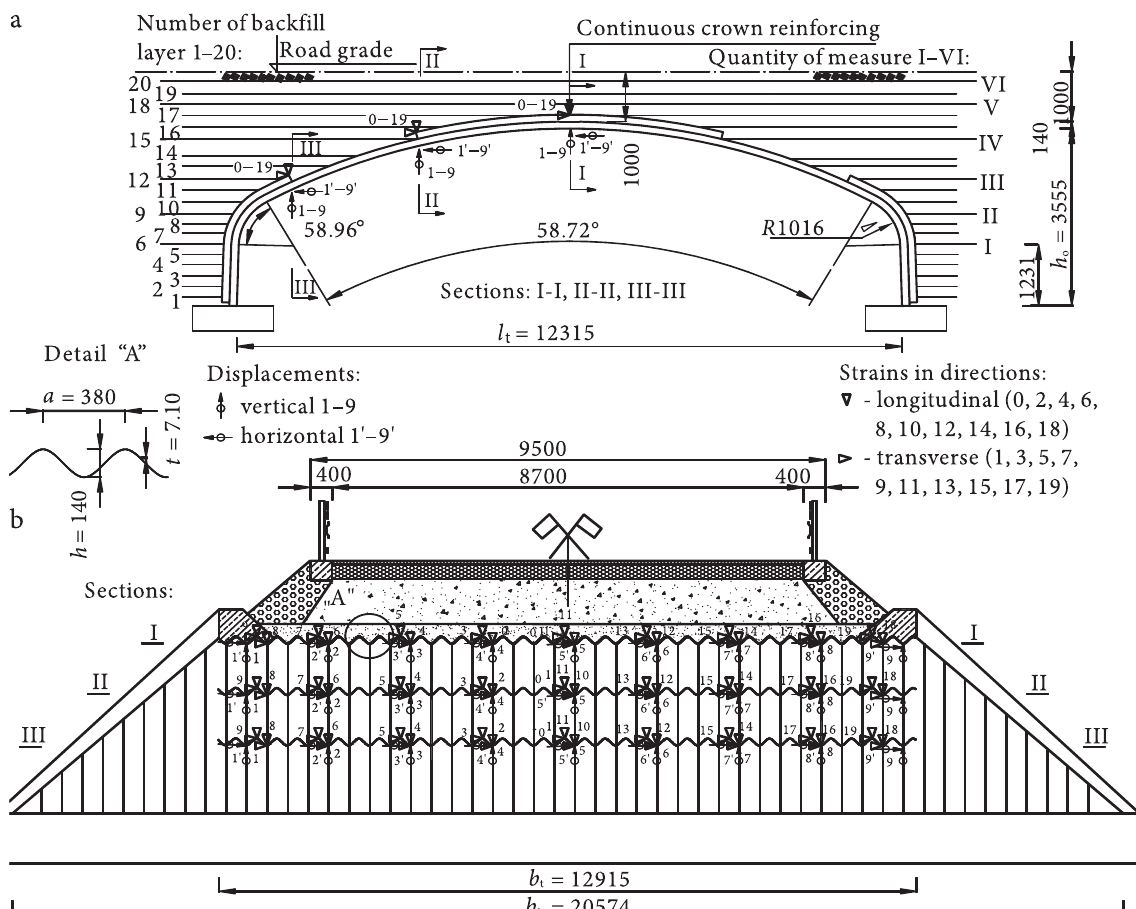
fig. 4. Road bridge in Gimån (Sweden), made from corrugated plates: a – geometry of longitudinal section; b – cross-section I–I localization of dial gages and extensometers served measuring of vertical (horizontal) displacements and strains in longitudinal (transversal) directions, respectively (measurements in